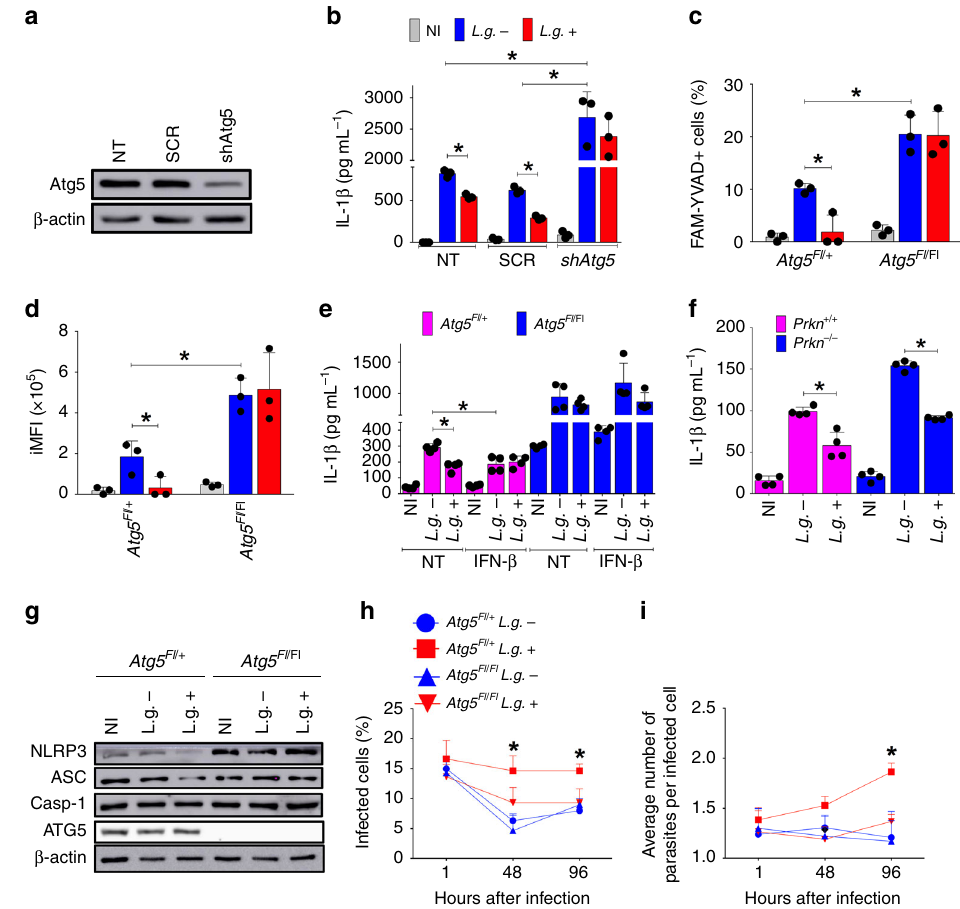
Fig. 6 LRV limits NLRP3 activation via ATG5. a , b C57BL/6 BMDMs were silenced with a scramble sequence (SCR) or Atg5 -speci fi c shRNA, then infected with L.g. − or L.g . + , and the ef fi ciency of the process ( a ) was con fi rmed by WB. β -actin: loading control. b After 24 h of infection, levels of IL-1 β were determined by ELISA in cell-free supernatants. NT: Non-transduced BMDMs. c , d BMDMs from LysM Cre/ + / Atg5 Fl/ + (Littermate control) or LysM Cre/ + / Atg5 Fl/Fl (Knockout) mice were infected with L.g. − or L.g . + for 24 h, and Casp1 activation was determined by FLICA assay (FACS). The percentage of Casp1 + cells (FAM-YVAD) ( c ) and iMFI ( d ) are shown. e LysM Cre/ + / Atg5 Fl/ + and LysM Cre/ + / Atg5 F/Fl BMDMs were infected and left untreated or treated with IFN- β (1000 U/mL) at the moment of the infection. Levels of IL-1 β in cell-free SNs were quanti fi ed by ELISA, after 24 h of infection. f ELISA assay in Parkin de fi cient BMDMs ( Prkn − / − ) and its respective littermate control ( Prkn + / + ) after 24 h of infection. g WB for in fl ammasome components and ATG5 in LysM Cre/ + / Atg5 Fl/ + and LysM Cre/ + / Atg5 Fl/ Fl BMDMs after 24 h of infection with L.g. − or L.g . + . β -actin was used as a loading control. h , i BMDMs were infected with metacyclic promastigotes from either L.g. − or L.g . + , at a MOI of 1. One hour after infection, cells were washed and left in culture for 1, 48, or 96 h. The percentage of infected cells ( h ) and the average number of amastigotes per cell ( i ) was evaluated by Panotico Giemsa . The results are shown as mean ± SD. Statistical analysis was performed by unpaired Student ’ s t test. P < 0.05 (*) was considered statistically signi fi cant. One representative of